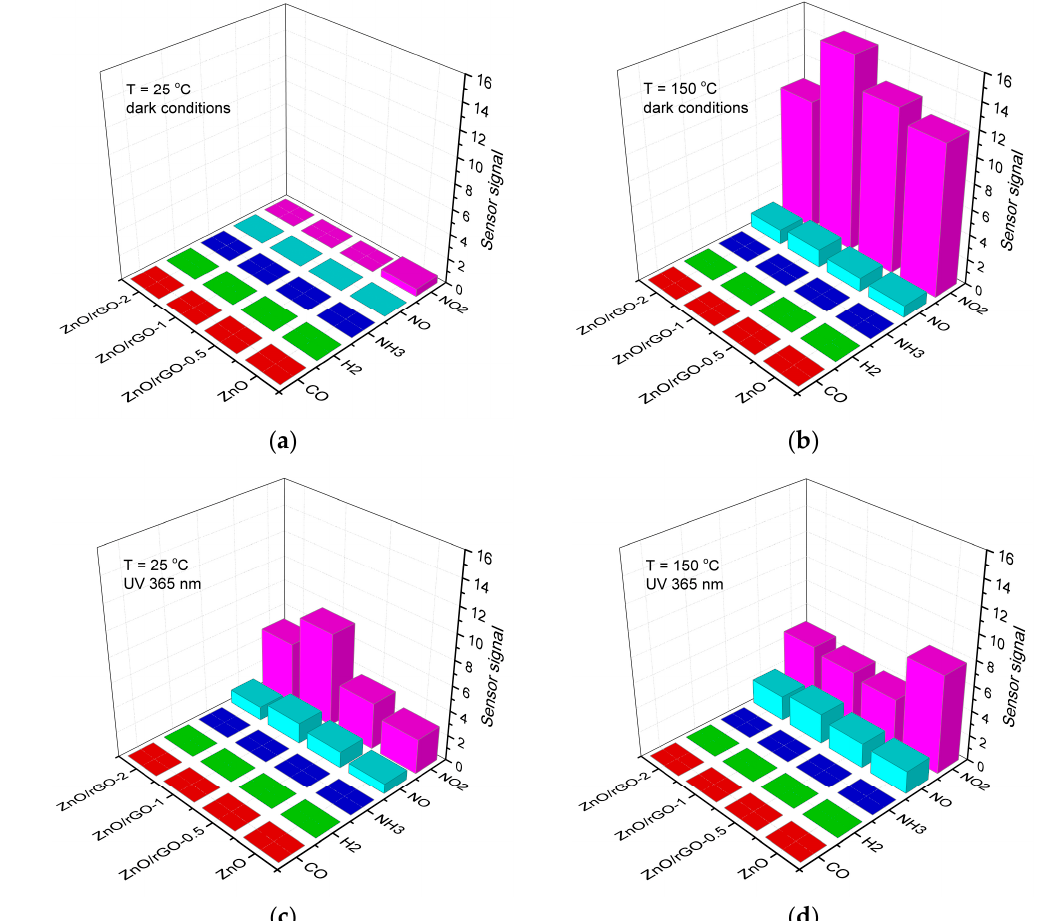
Figure 6. Dynamic change in sensors’ resistance with periodic changes in the gas phase composition